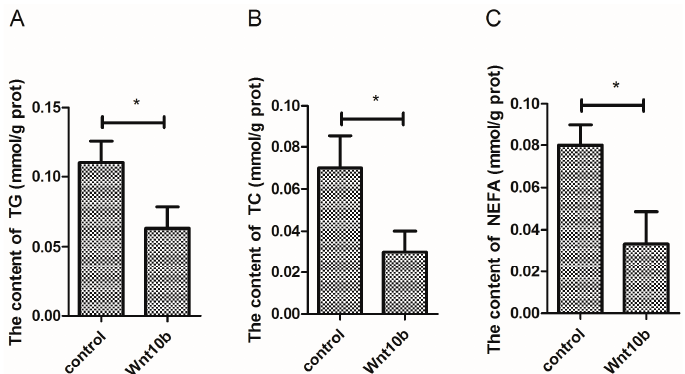
Figure 4. Effect of Wnt10b gene overexpression on the content of triglyceride (TG), total cholesterol (TC), and non-esterified fatty acids (NEFA) in the muscle. ( A ) TG; ( B ) TC; ( C ) NEFA. Values are expressed as means ± s.e.m. ( n = 4). Statistically significant differences are denoted by an asterisk (* p < 0.05). 3.5. Effect of Wnt10b Gene Interference on the Gene Expression of Wnt10b, GSK-3 β , β -catenin, C/EBP α , and PPAR γ The interference of Wnt10b gene significantly decreased the mRNA expression of Wnt10b and β -catenin (Figure 5A,C), but significantly increased the expression of GSK-3 β in the muscle (Figure 5B). Moreover, silencing Wnt10b gene significantly decreased the mRNA expression of C/EBP α and PPAR γ (Figure 5D,E).